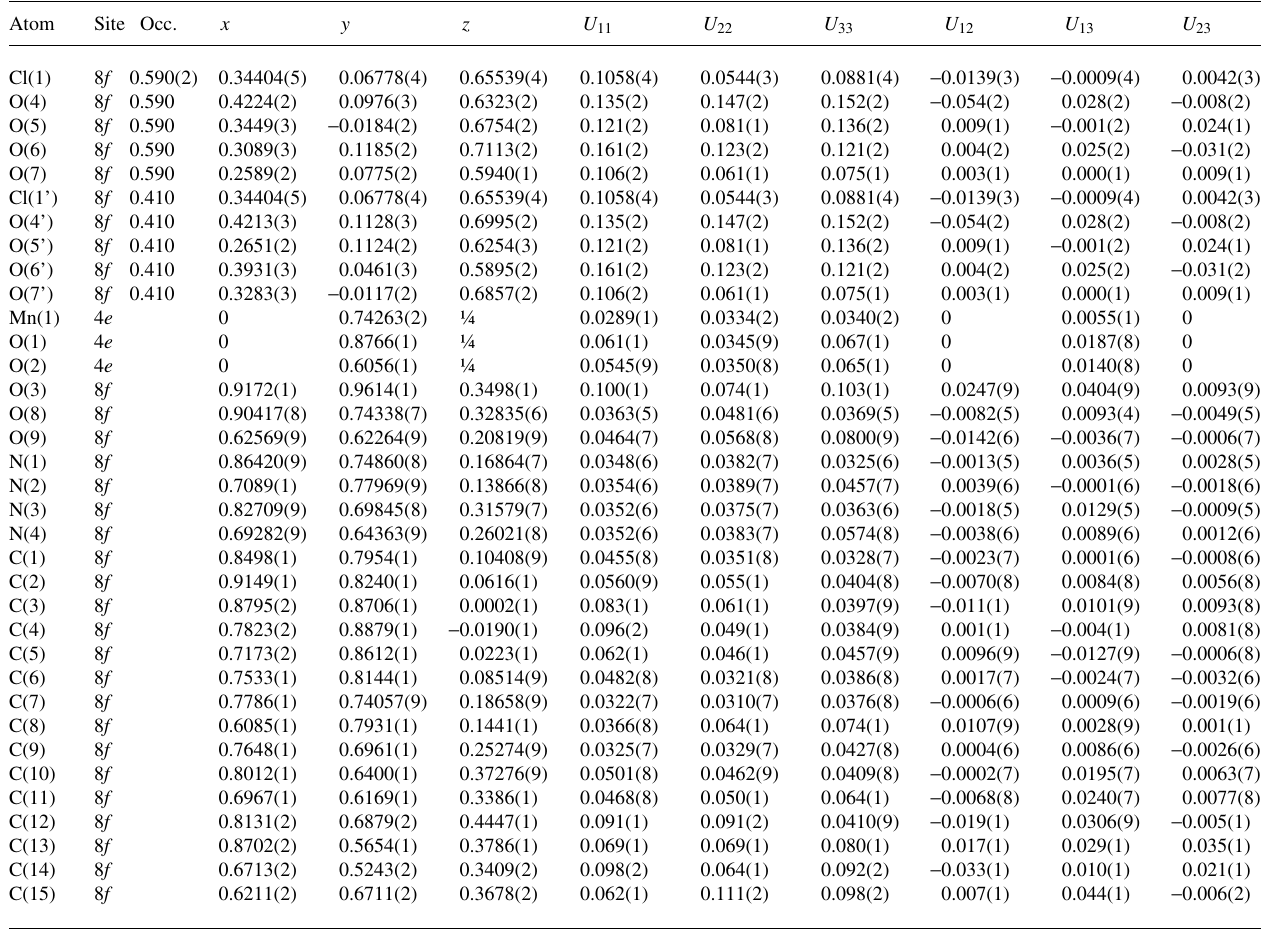
Table 3. Atomic coordinates and displacement parameters (in Å 2 ) .